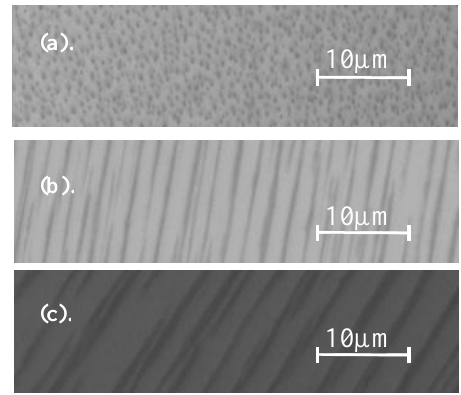
Figure 7. Superparamagnetic micro particles. (a) Microparticles in absence of external magnetic field; (b) and (c) Structure of the microparticles under the influence of increasing external magnetic field.